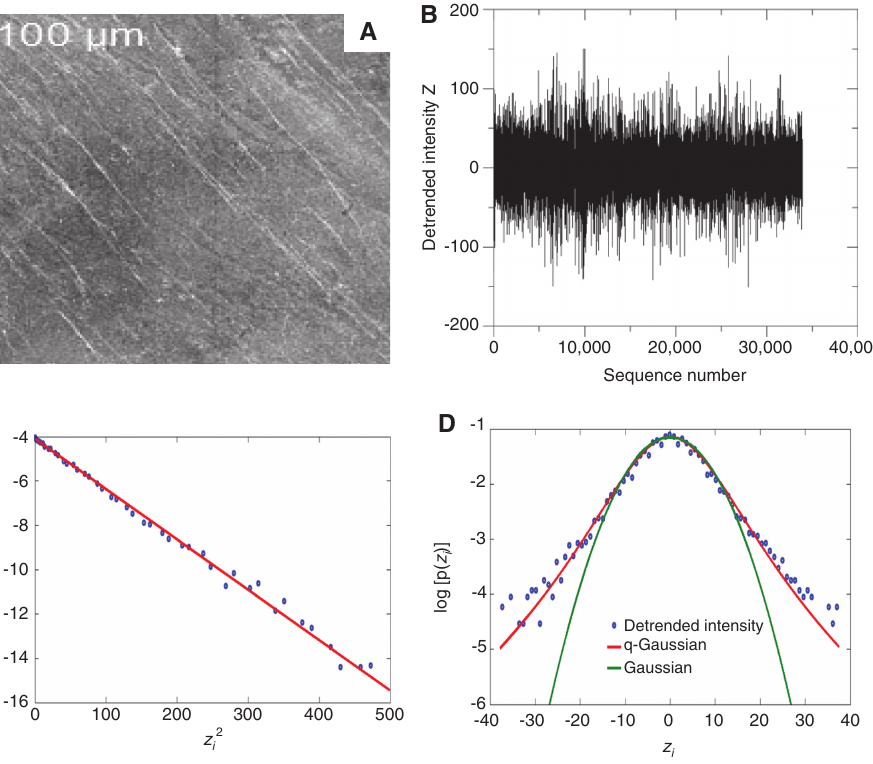
Figure 3: (A) SEM image showing the shear band formation on the surface of the sample compressed at strain rates 10 -2 s -1 for ε = 0.2, at low magnification 100 μ m, [22]. (B) Detrended intensity series. (C) Best linear correlation between ln (D) log[ p ( z )] vs. z for the detrended image series (blue circles), the theoretical q -Gaussian (red line), and the normal Gaussian i i (green line).